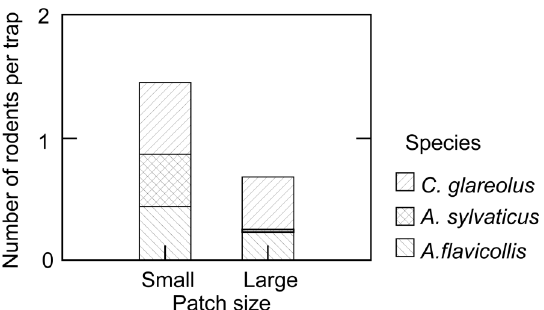
density.Fig 2. Indices of rodent density. The index is the number of indi- vidual rodents captured in a site (each individual may have